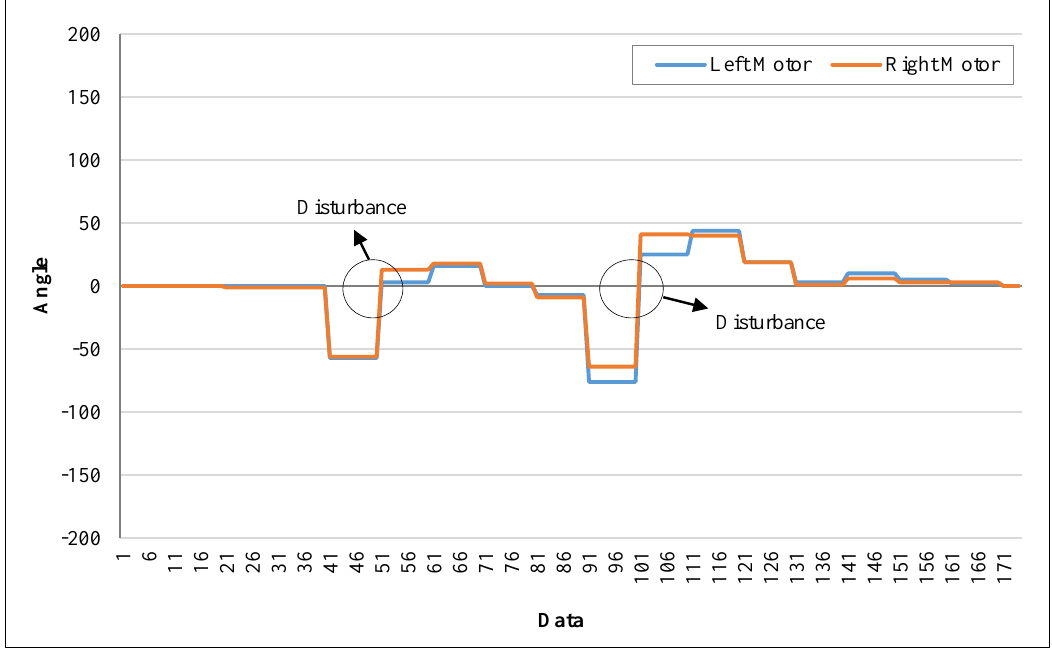
Figure 20. Motor speed response to